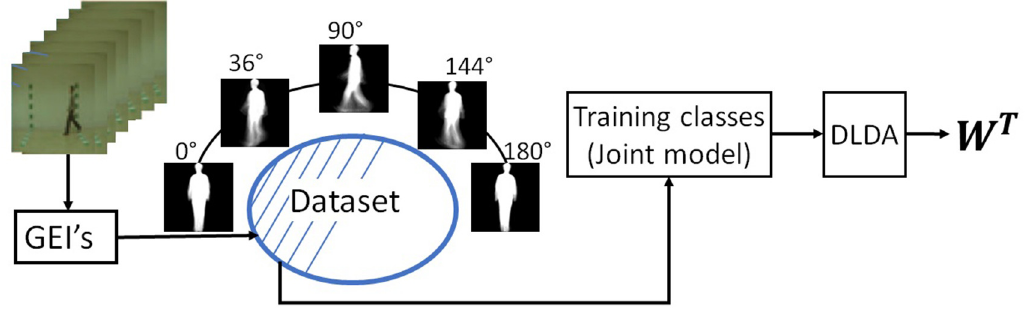
Figure 1. Proposed scheme for constructing the unique projection